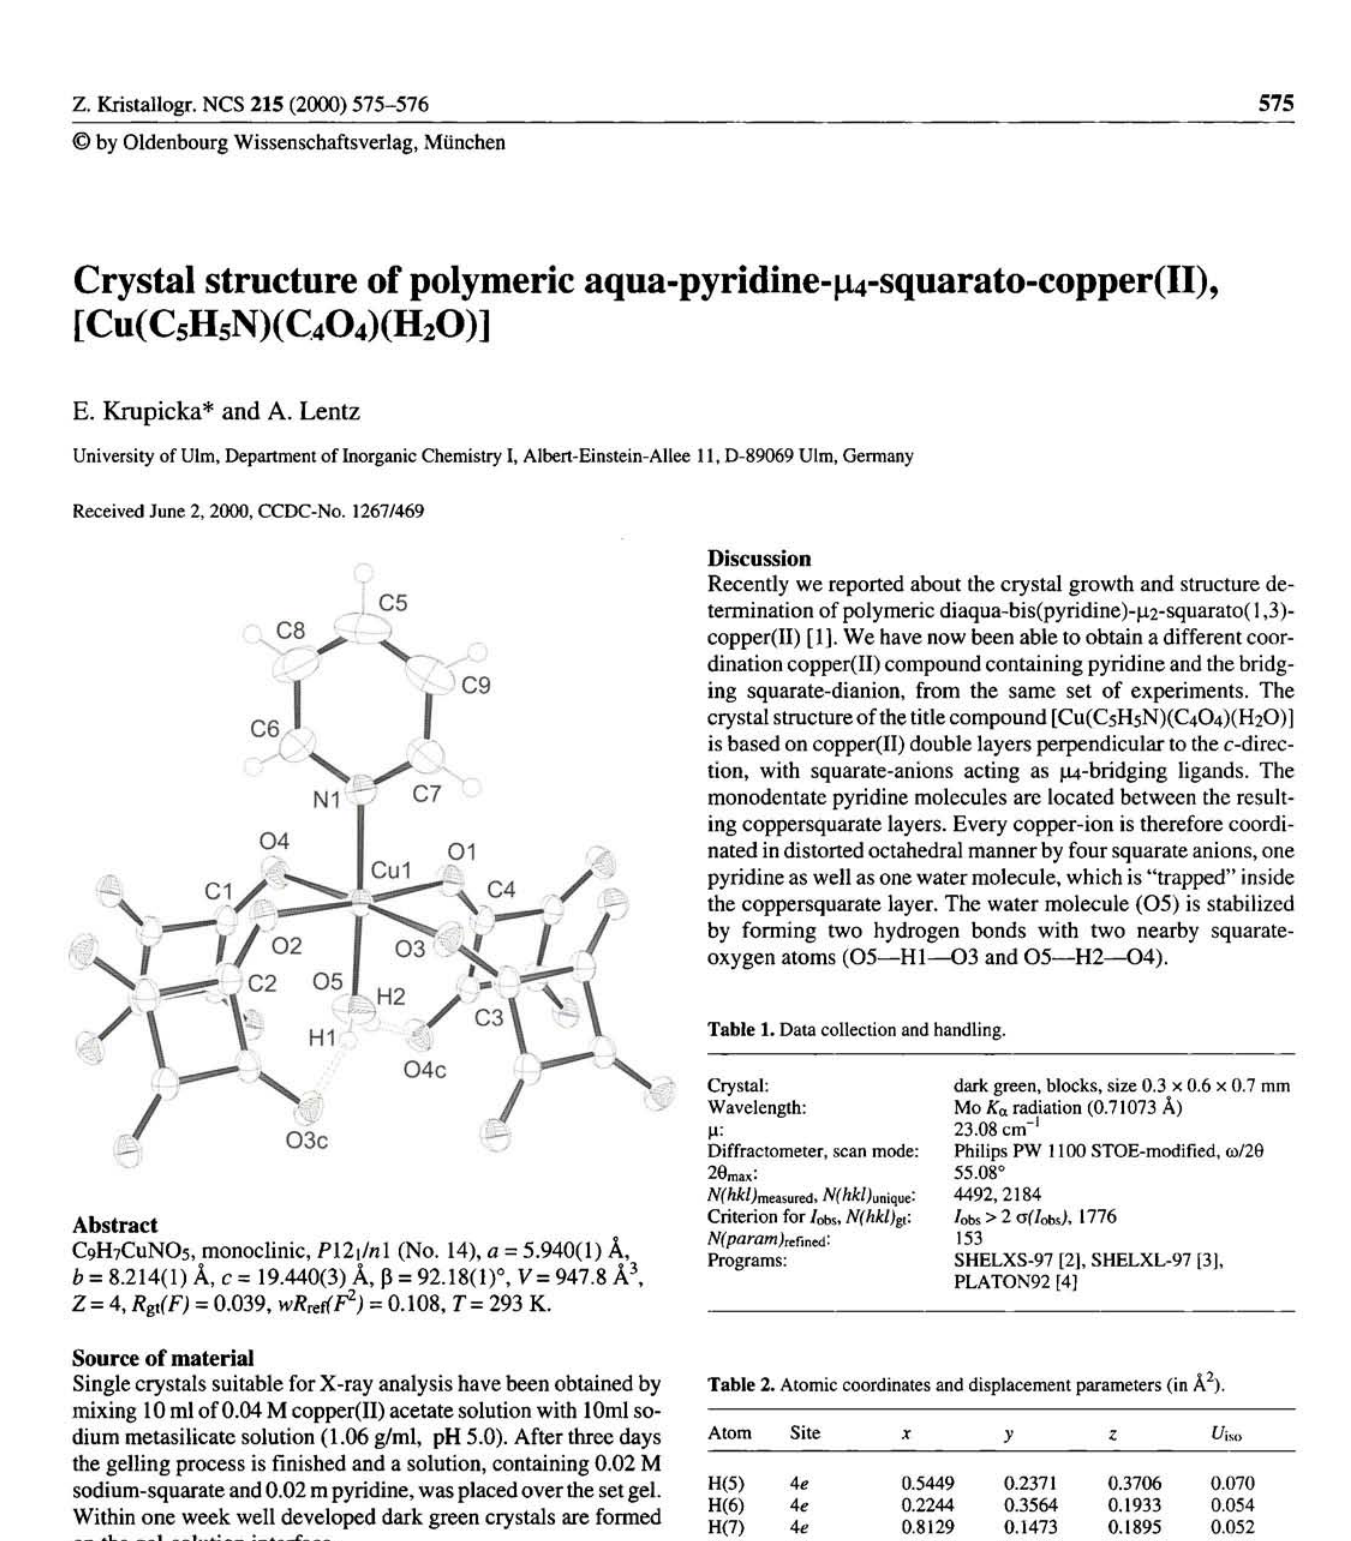
Table 2. Atomic coordinates and displacement parameters (in À